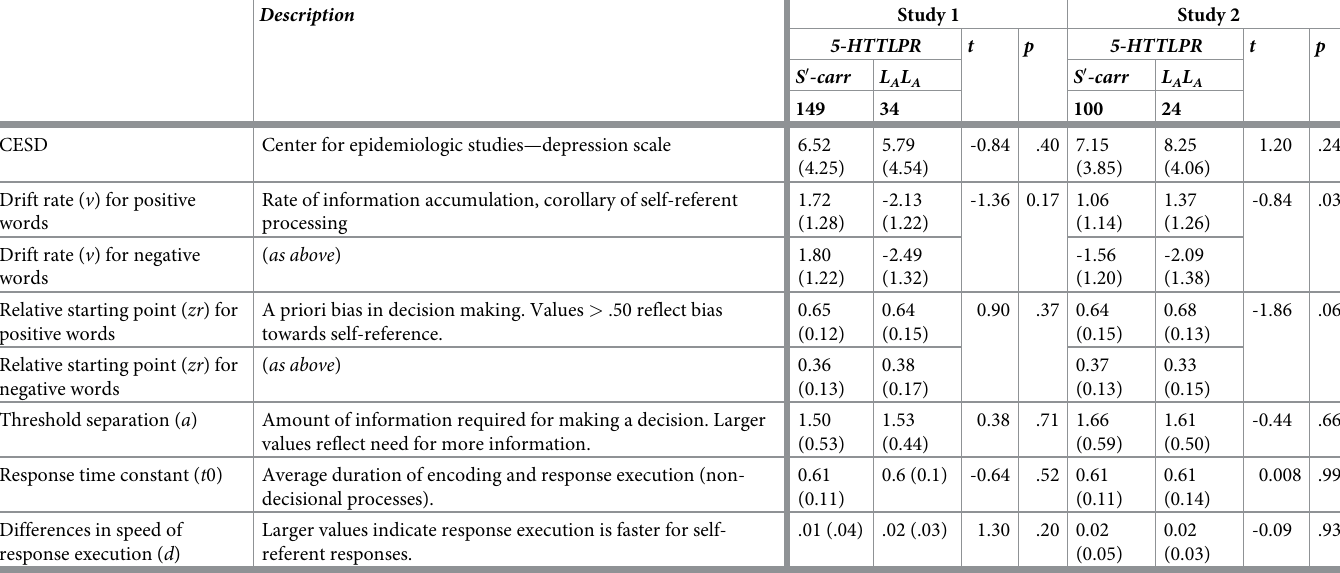
Table 1. Means (SD) for depressive symptoms and diffusion model parameters presented as a function of 5-HTTLPR genotype.